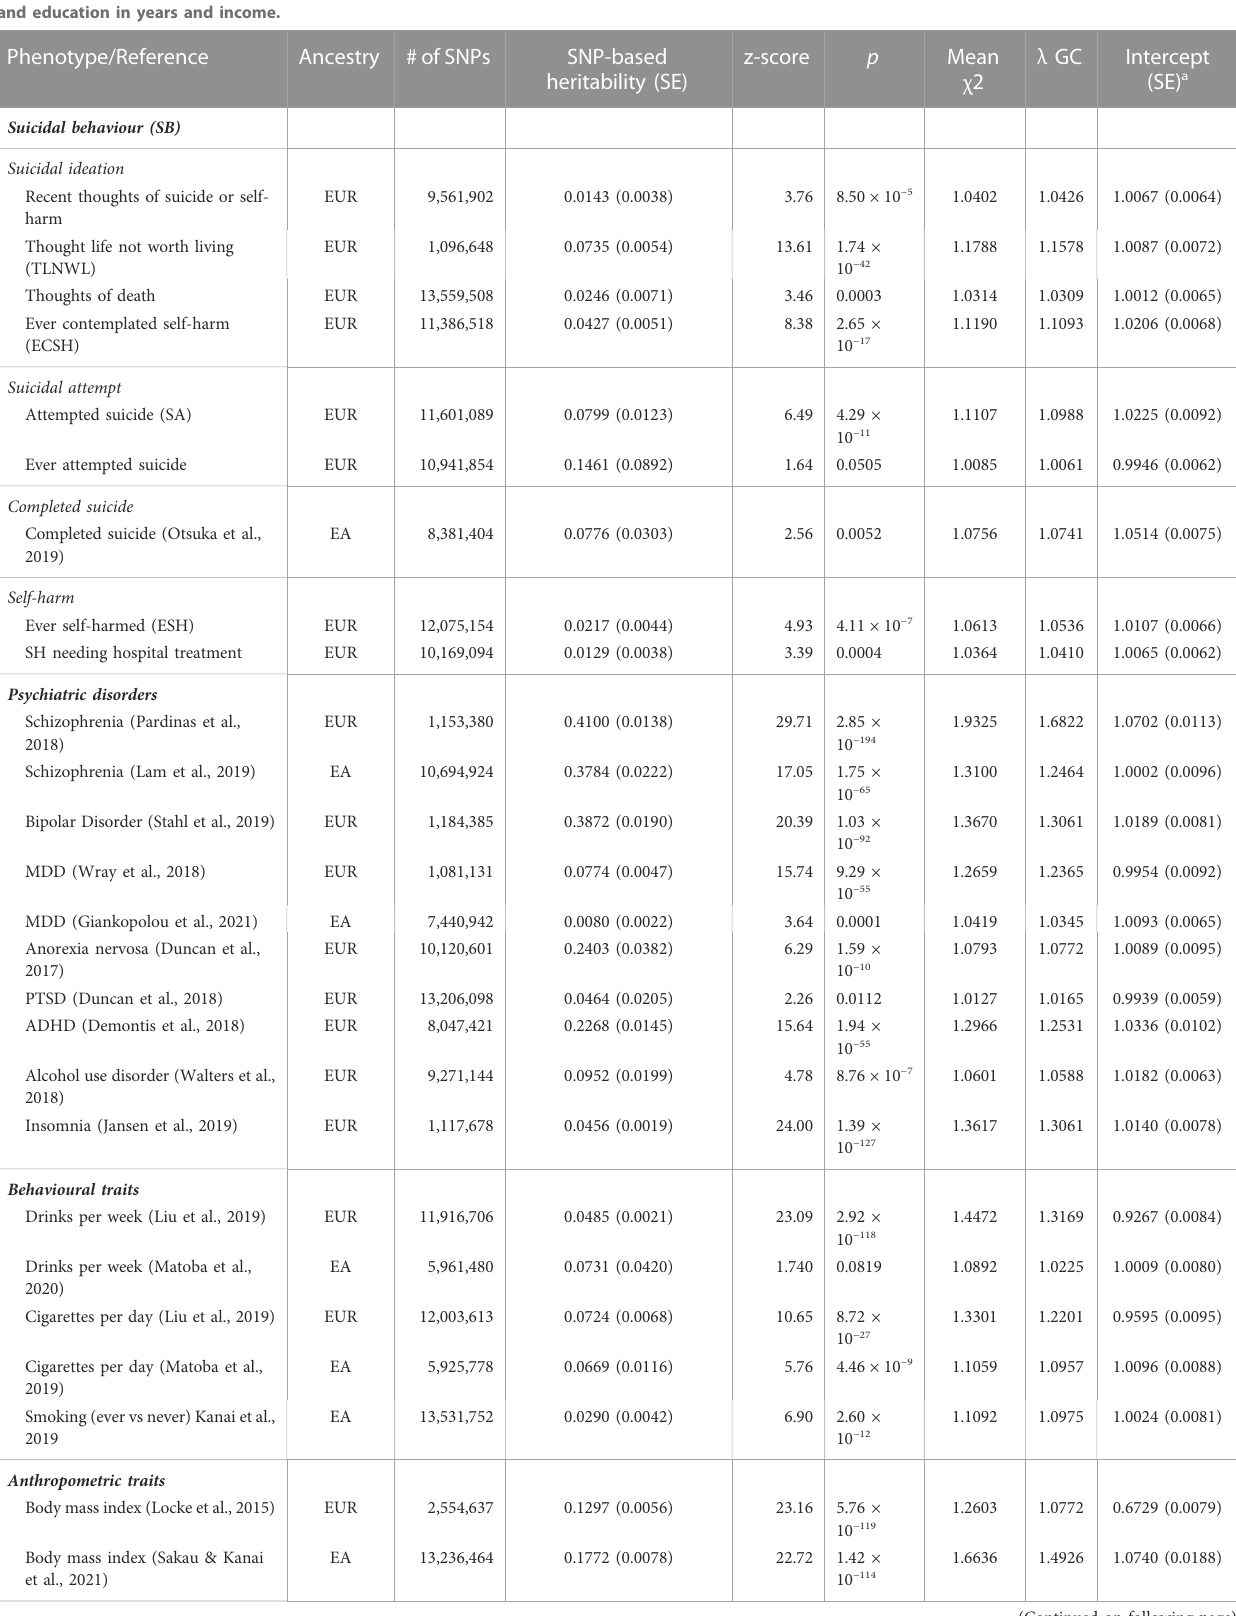
TABLE 2 Results of univariate SNP-based heritability estimates using LD-score regression of predicted probability of suicidal behaviour (SB), psychiatric disorders and education in years and